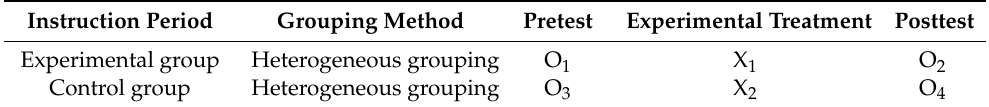
Table 1. Instruction experimental